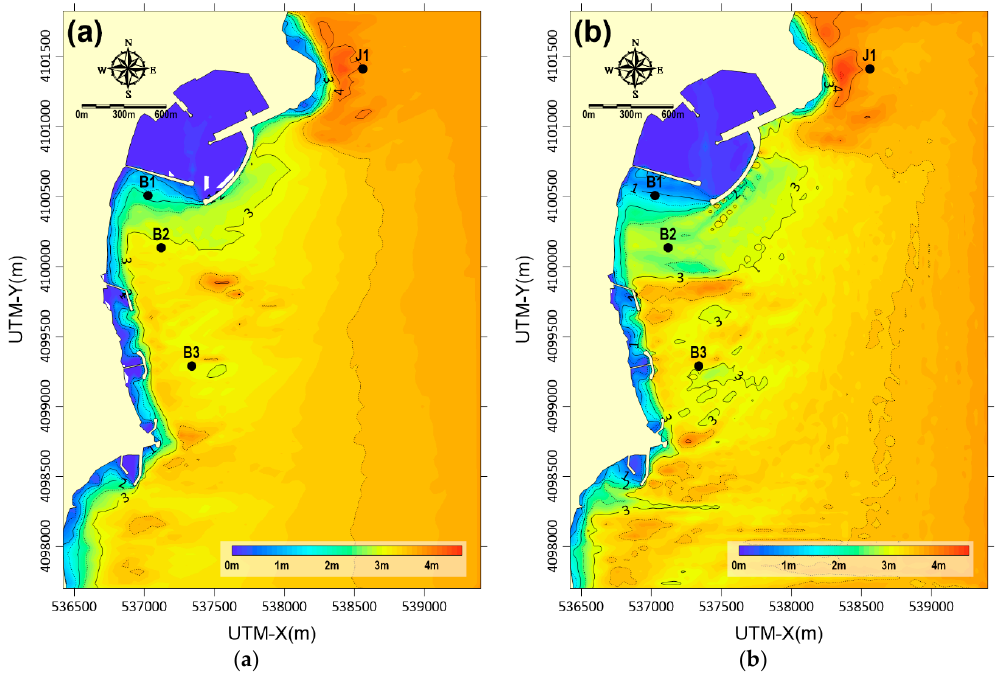
Figure 9. Distributions of wave heights modeled by ( a ) TELEMAC–TOMAWAC and ( b ) TEL EMAC–ARTEMIS, Case 2. Table 3. List of wave parameters calculated from the model results, Case 2. The percentages in the parenthesis are the model errors from the